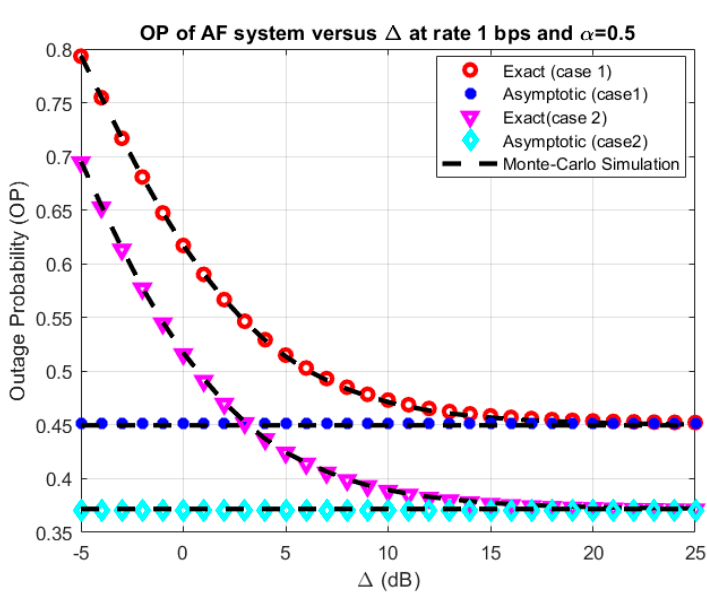
Figure 4. OP versus Δ .